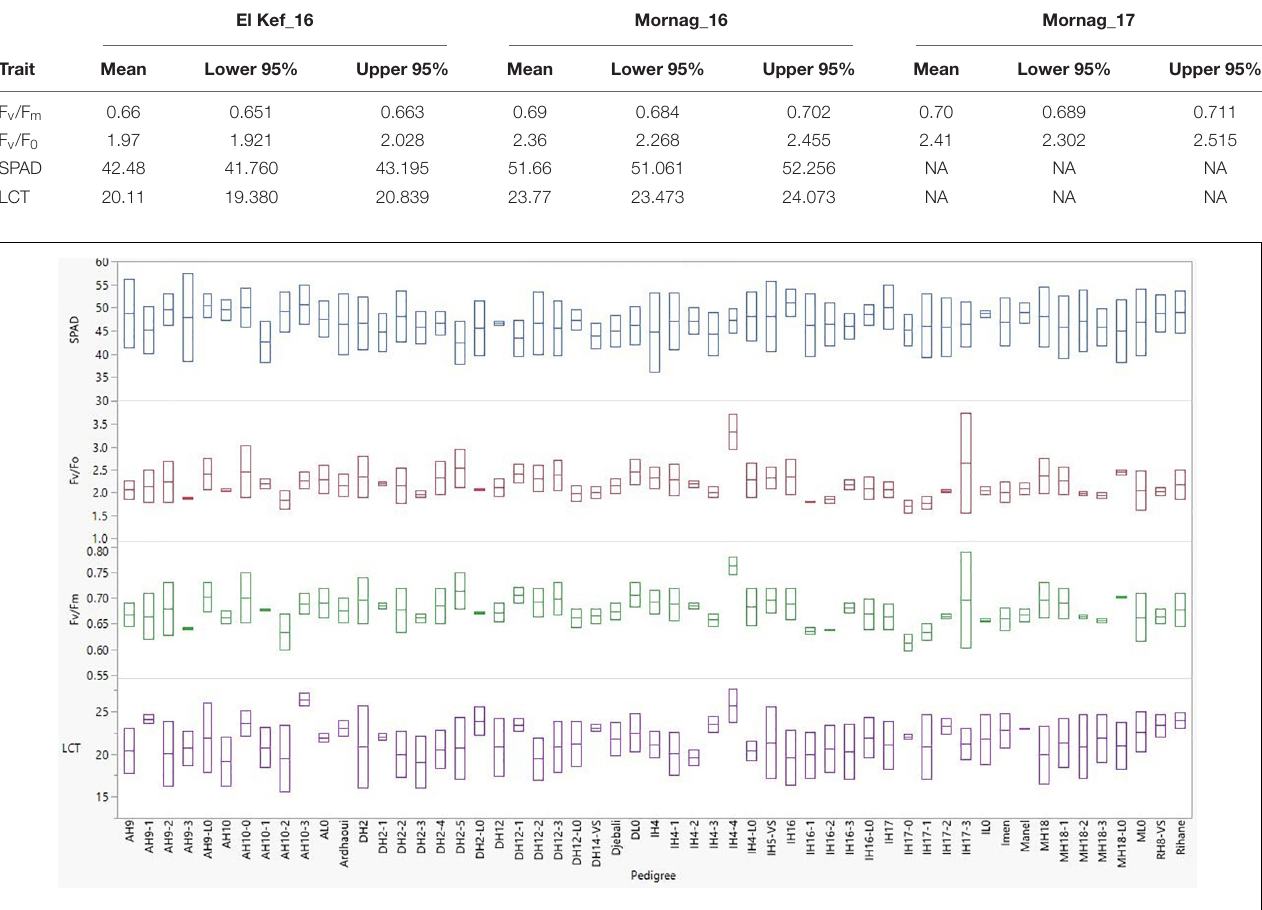
TABLE 6 | Physiological parameters means and confidence intervals of barley entries evaluated in different environments in Tunisia. El Kef_16